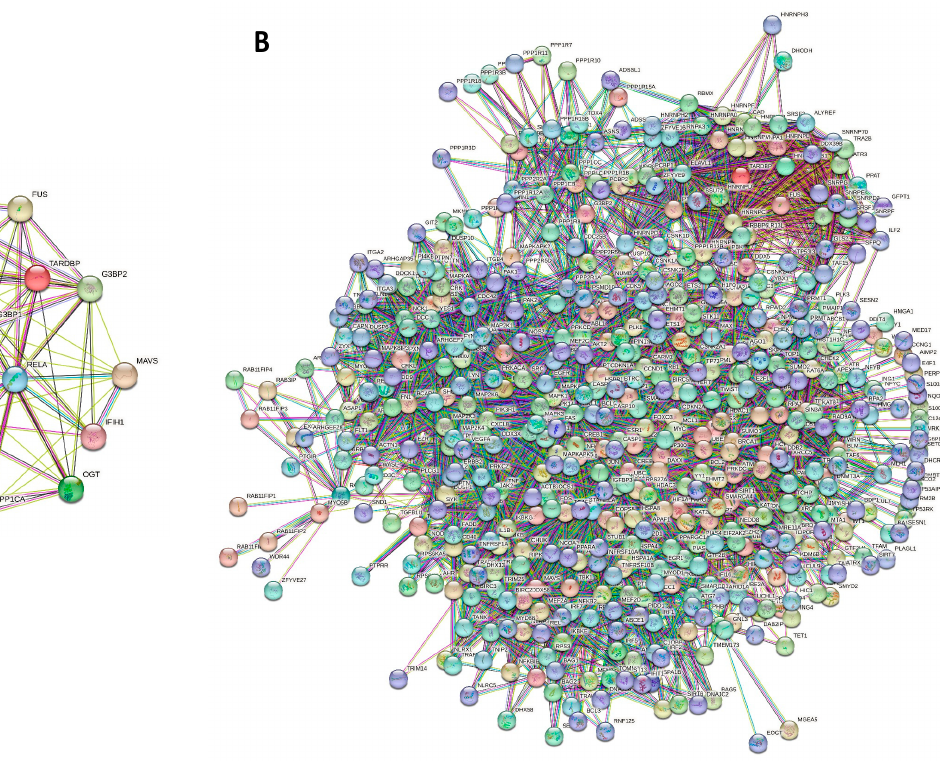
Figure 5. Internal ( A ) and external PPI networks ( B ) of 17 human proteins recruited to MLOs related to viral infection. Networks were generated by STRING (http://string-db.org/) (accessed on 9 December 2022), which creates a network of associations based on predicted and experimentally validated information on the interaction partners of a protein of interest. In the corresponding network, the nodes correspond to proteins, whereas the edges show predicted or known functional associations. Seven types of evidence are used to build the corresponding network and are indicated by the differently colored lines: a green line—neighborhood evidence; a red line—presence of fusion evidence; a purple line—experimental evidence; a blue line—co-occurrence evidence; a light blue line—database evidence; a yellow line—text mining evidence; and a black line—co-expression evidence. Interactive maps of internal and external PPI networks can be found at: https://string-db.org/cgi/network?taskId=bUhEOdNrRfH9&sessionId=bxLUgl7X6fKS (last accessed on 2 January 2023) and https://string-db.org/cgi/network?taskId=beMc7yqPboZj&sessionId=bxLUgl7X6fKS (last accessed on 2 January 2023).